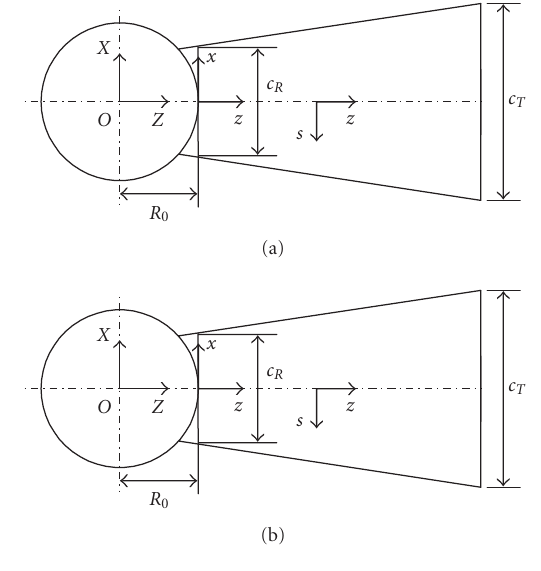
Figure 1: Geometric configuration of the rotating blade. Here σ > 1.